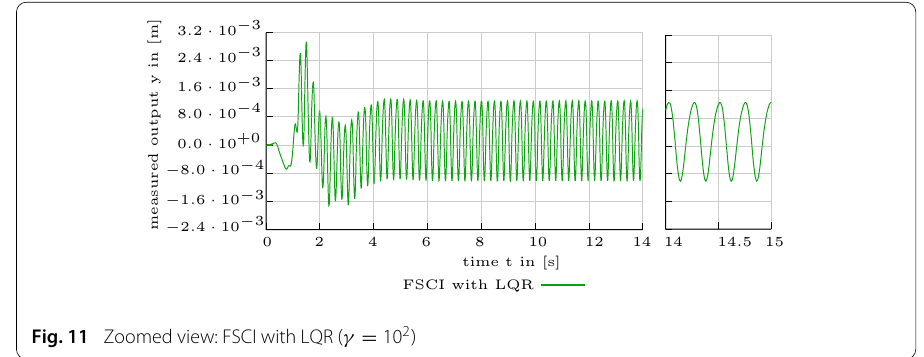
Fig. 11 Zoomed view: FSCI with LQR ( γ = 10 2 )